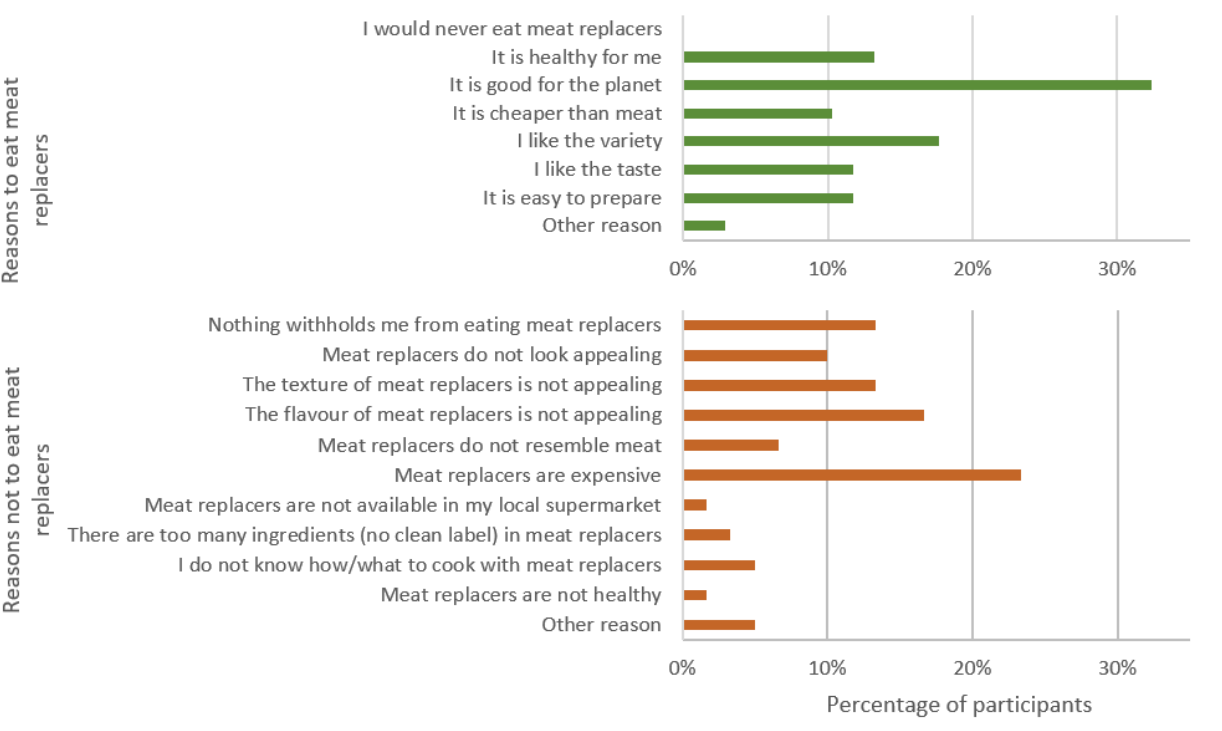
Figure 4. Reasons to ( top ) or not to ( bottom ) eat meat replacers ( n = 71). Of all the products, real meat was liked better than the meat analogues. Next to